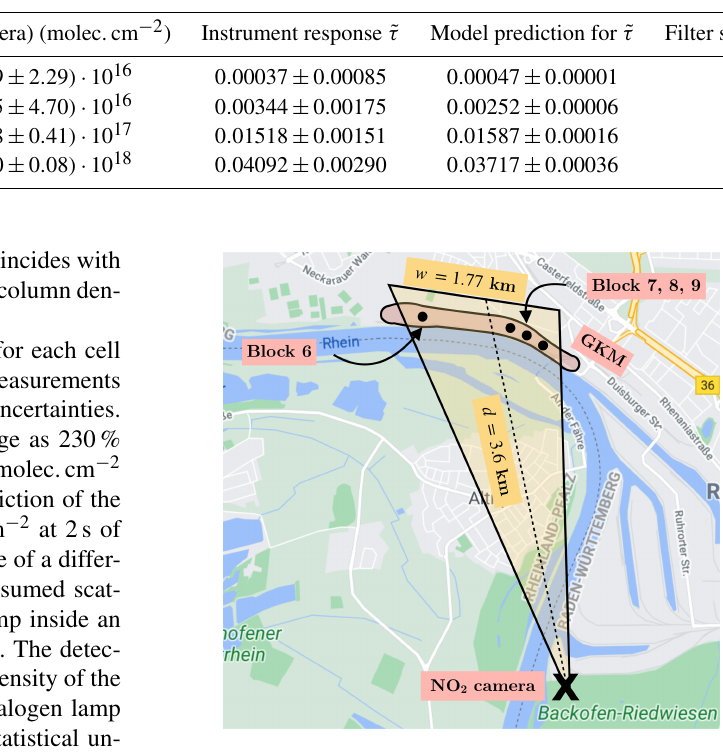
Figure 11. The GKM measurement in bird’s-eye perspective (© Google Maps 2021). The NO 2 camera was set up at Backofen- Riedwiesen, 3.6km south of the GKM, and positioned so that the emission of block 7 was in the middle of the